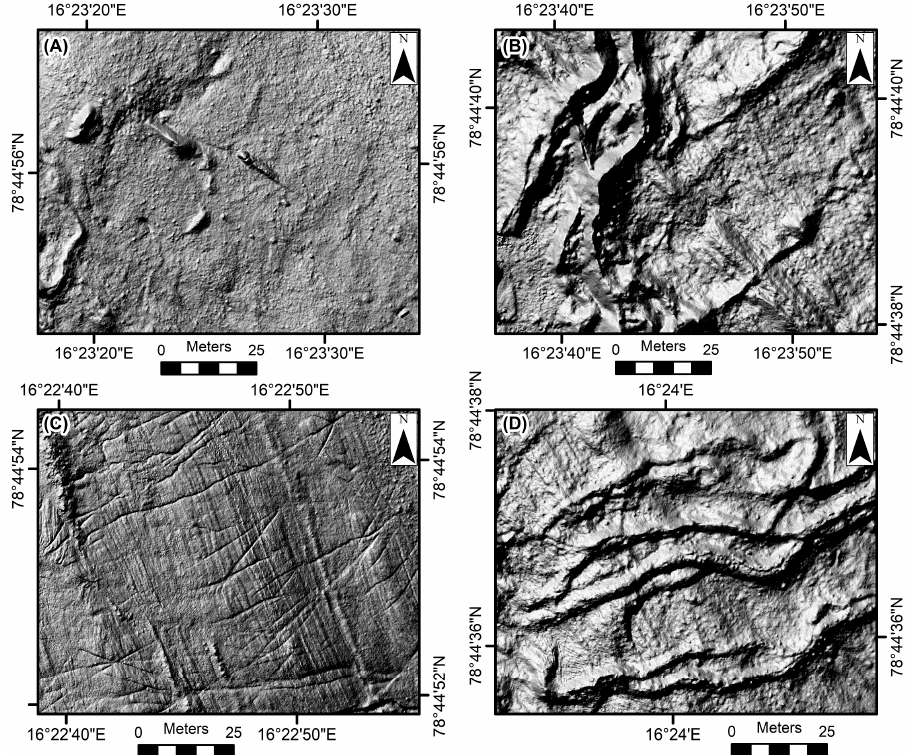
Figure 4. Samples of full-resolution (7.9 cm GSD) digital elevation models (DEMs) visualized using hillshading. Foreland of Hørbyebreen, Svalbard. Note that it is possible to recognize: ( A ) Very small and short flutes anchored behind the boulders; ( B , D ) Several types of cross-cutting ridges characterised by different orientation, width and height; ( C ) At least several types of glaciological structures including transverse surface fractures (crevasse traces) and longitudinal foliations.